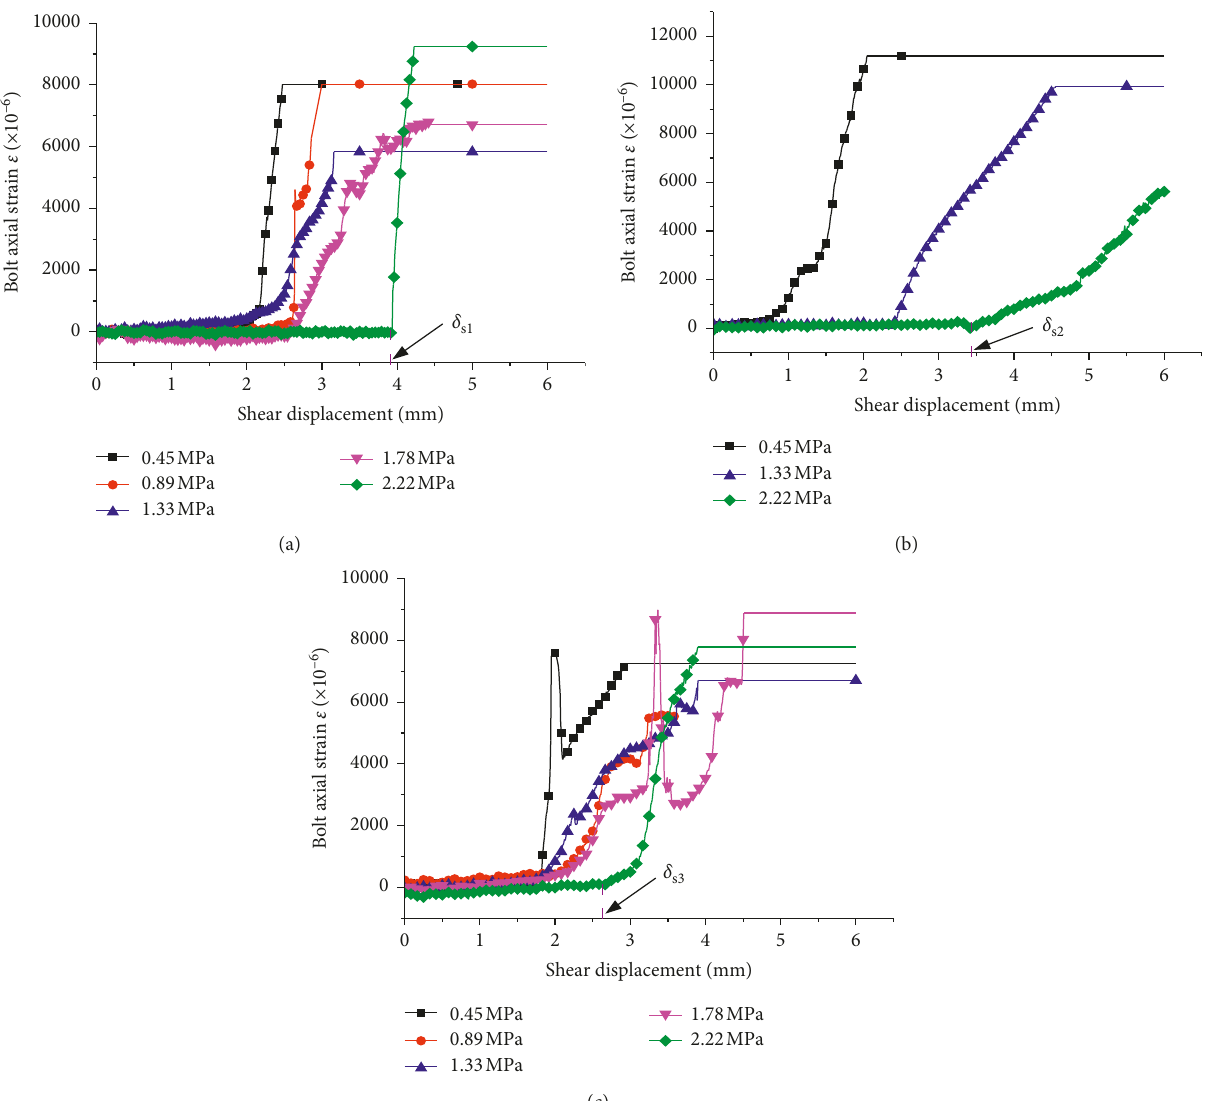
Figure 5: Strain-displacement curve of the grouted joint with one bolt (a), two bolts (b), and three bolts (c) of 45 °